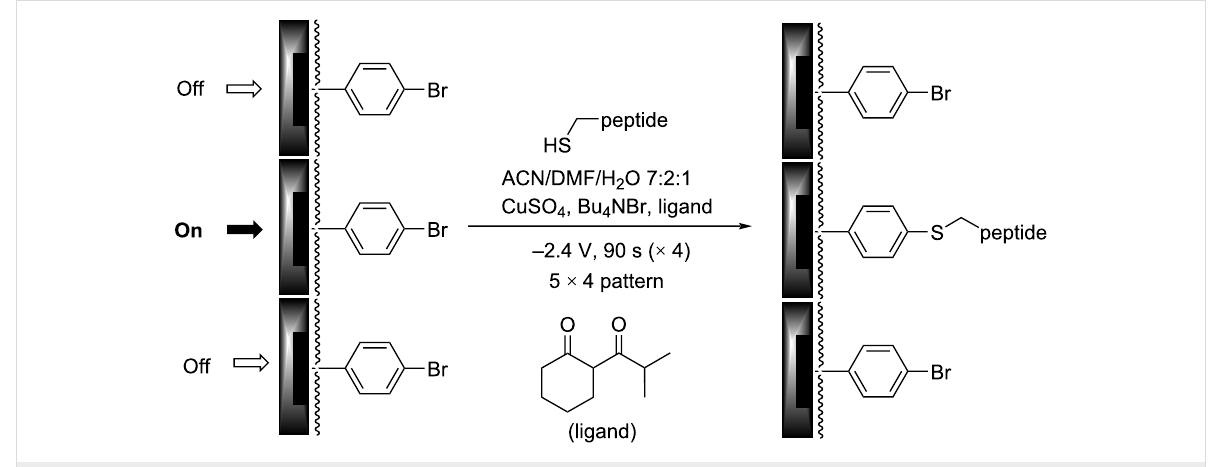
Scheme 1: A Cu(I)-catalyzed cross-coupling reaction on an array.